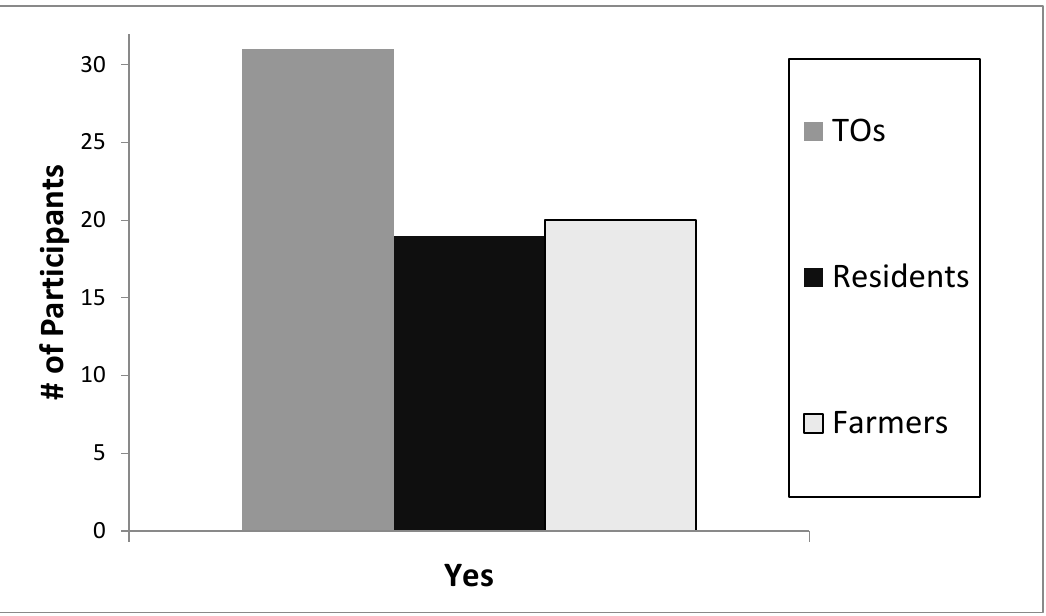
Figure A9. Participant #’s (by stakeholder group) that drink untreated water from basin waterways. Interviewees were also asked if they knew of any recent water quality reports for the GBR (i.e., the GBR baseline report, 1st Report Card based on water quality data from 2009; or pesticide reports). Only 38% percent of Traditional Owners knew of these water quality reports while 68% of local